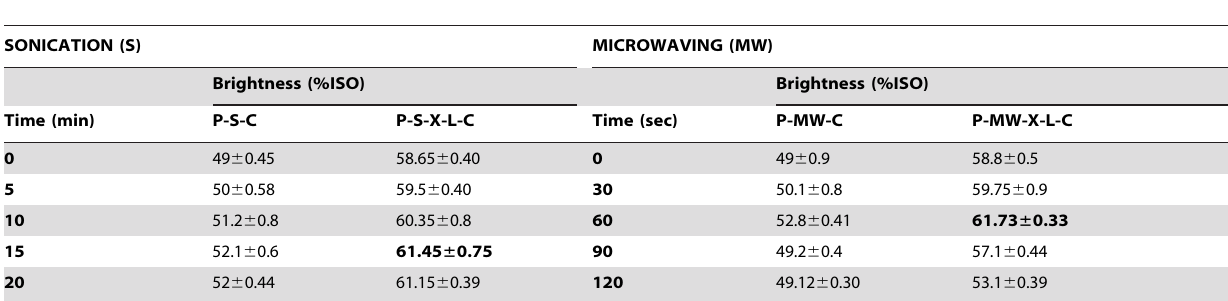
Table 5. Optimization of parameters for sonication (S) and microwave (MW) treatment of ONP pulp.